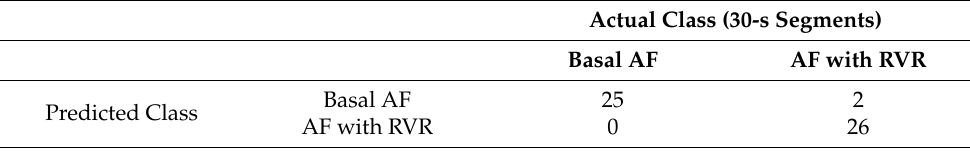
Table 5. Confusion Matrix for Training Stage of AF with RVR